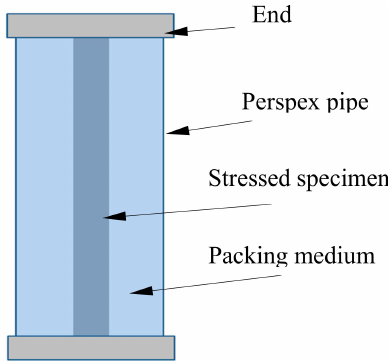
Figure 7. Long-term cable-bolt coupon test arrangements.